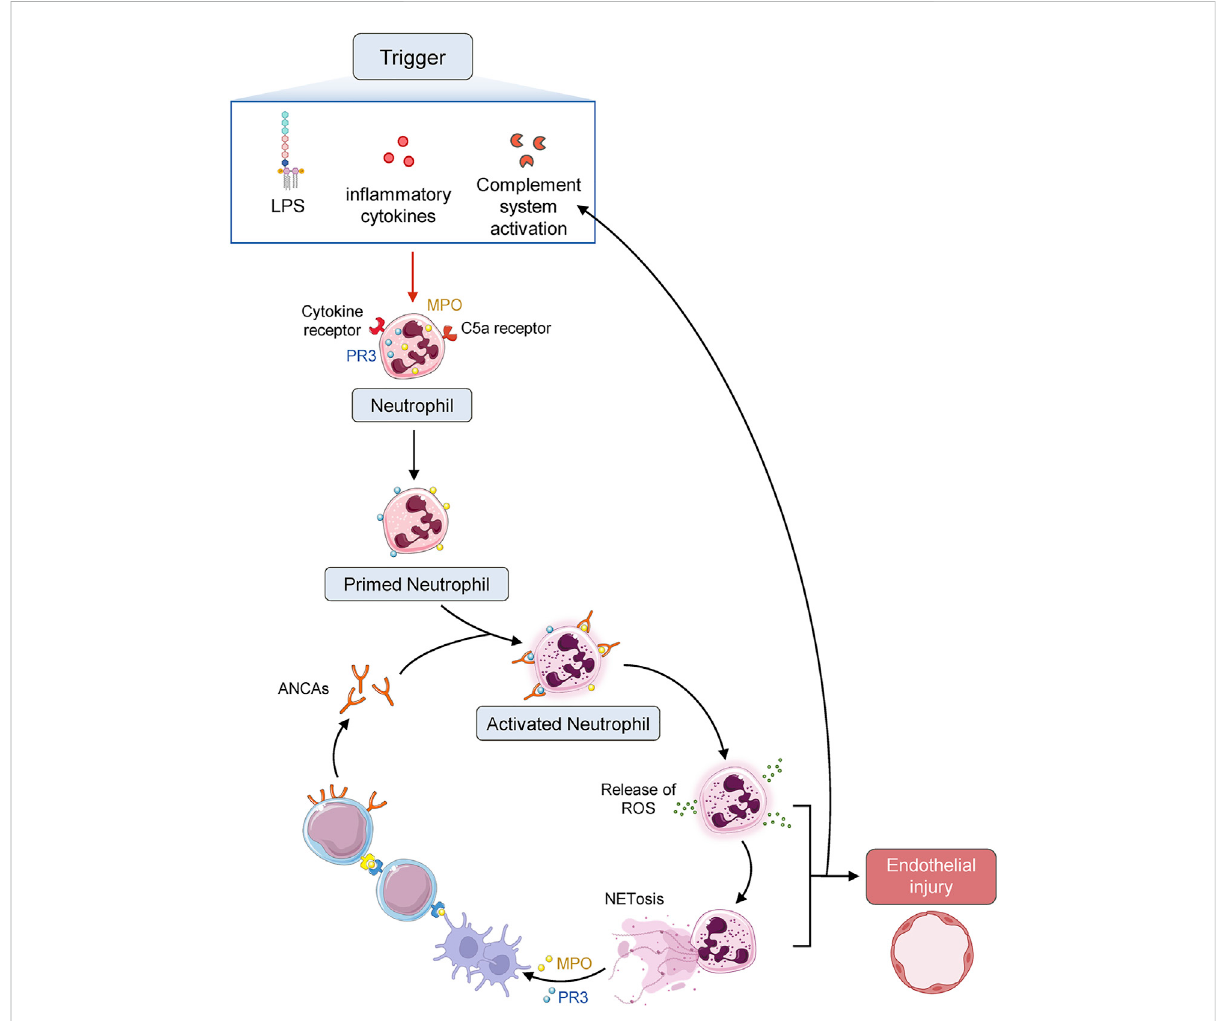
FIGURE 1 DiagrammaticsketchofAAVpathogenesis.ANCAautoantigensproteinase3(PR3)andmyeloperoxidase(MPO)identi fi edbyANCAarenormally sequestered in the primary granules of neutrophils. Infection or other environmental stimuli result in neutrophil priming, with the movement of PR3 and MPO to the cell surface and activate the neutrophils, which adhere to the vascular endothelium. Neutrophil degranulation leads to the release of reactive oxygen species (ROS), proteases, and neutrophil extracellular traps (NETs), damaging the endothelium. Chemokines and tissue deposition of PR3 and MPO lead to the recruitment of autoreactive T cells and monocytes, augmenting tissue